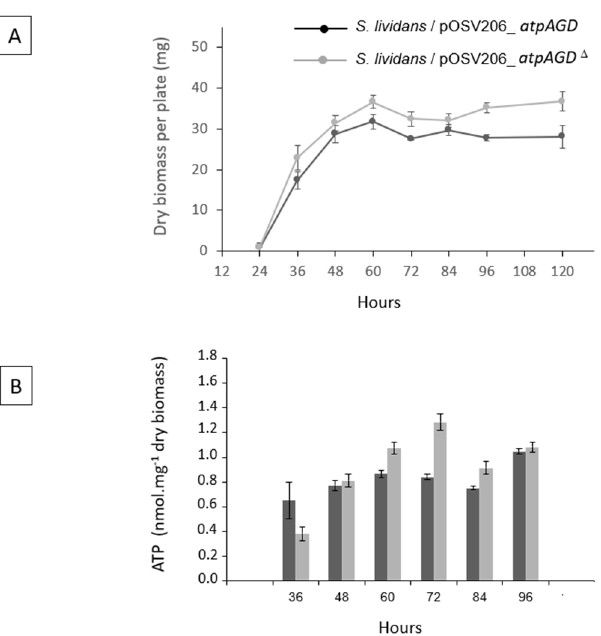
Figure 2. Growth curves of S. lividans /pOSV206_ atpAGD (black line) and S. lividans /pOSV206_ atpAGD ∆ (grey line) grown on solid HT medium ( A ) Assay of intracellular ATP concentration in S. lividans /pOSV206_ atpAGD (dark grey histograms) and S. lividans /pOSV206_ atpAGD ∆ (light grey histograms) at different points throughout growth ( B ).